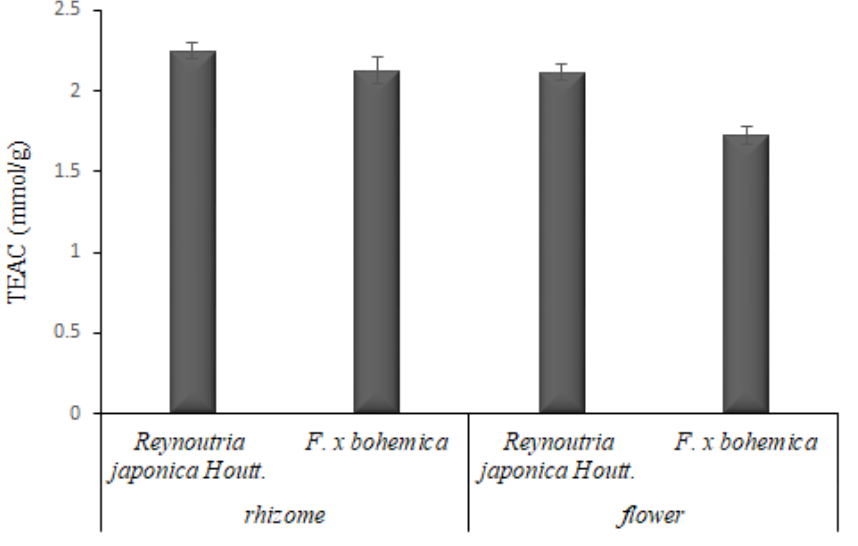
Figure 2. Antioxidant activity of knotweed extracts expressed as the Trolox equivalents (Trolox equivalent antioxidant capacity (TEAC), mmol / g). The data are presented as the average of two repetitions with the standard deviation.